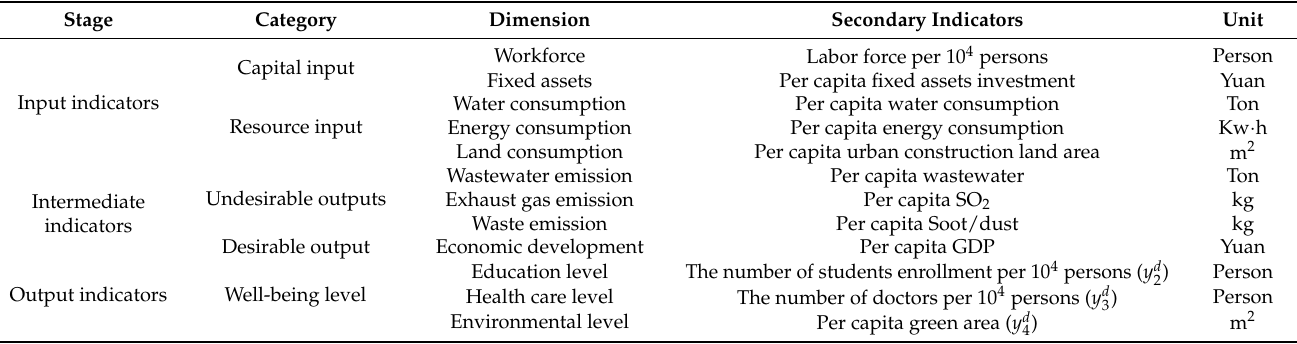
Table 1. The indicator descriptions of the EWP